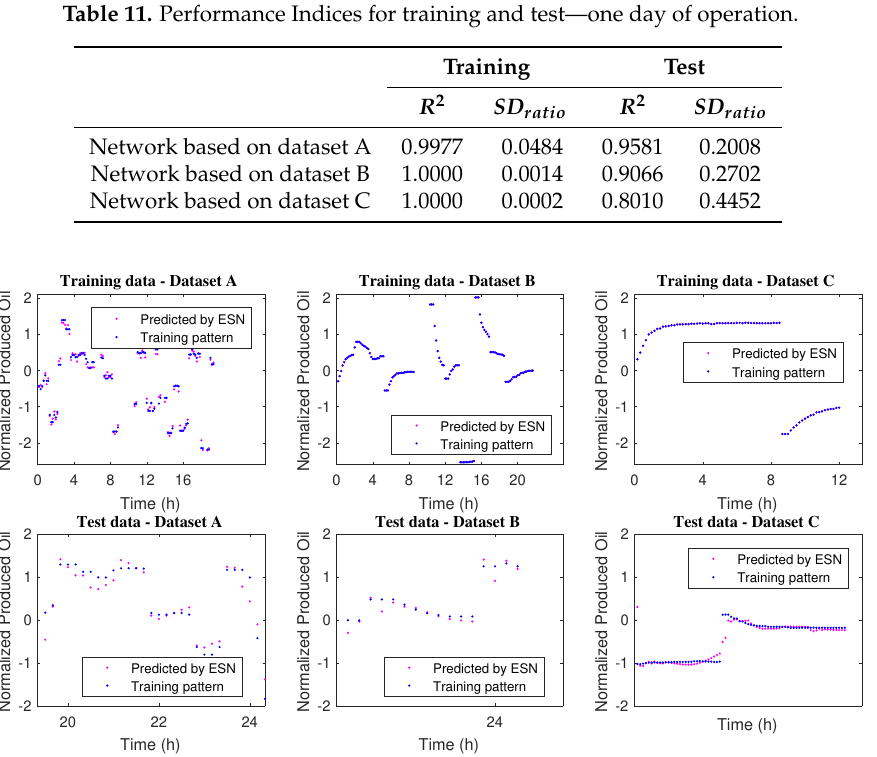
Figure 17. Training and test